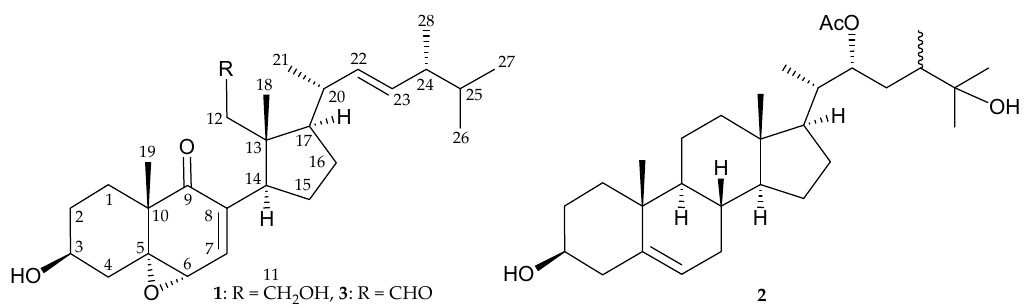
Figure 1. Chemical structures of 5 α ,6 α -epoxy-(22 E ,24 R )-3 β ,11-dihydroxy-9,11-secoergosta-7-en-9- one ( 1 ), (22 R )-acetoxy-(24 ξ )-ergosta-5-en-3 β ,25-diol ( 2 ), and 3- O -deacetylluffasterol B ( 3 ) [7].